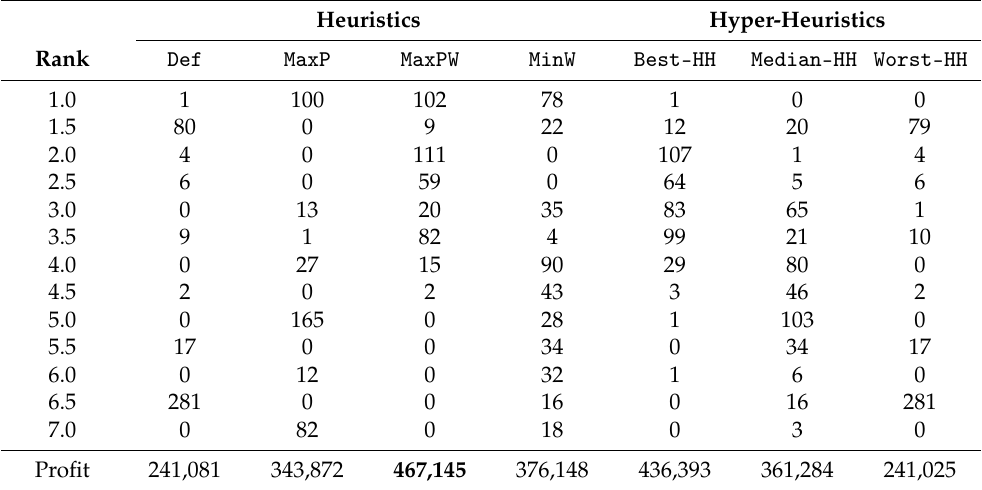
Table 2. Ranks and total profit obtained by the four heuristics and the best, median, and worst randomly generated hyper-heuristics when tested on set α 2 . The best result, measured in terms of total profit, is highlighted in bold.